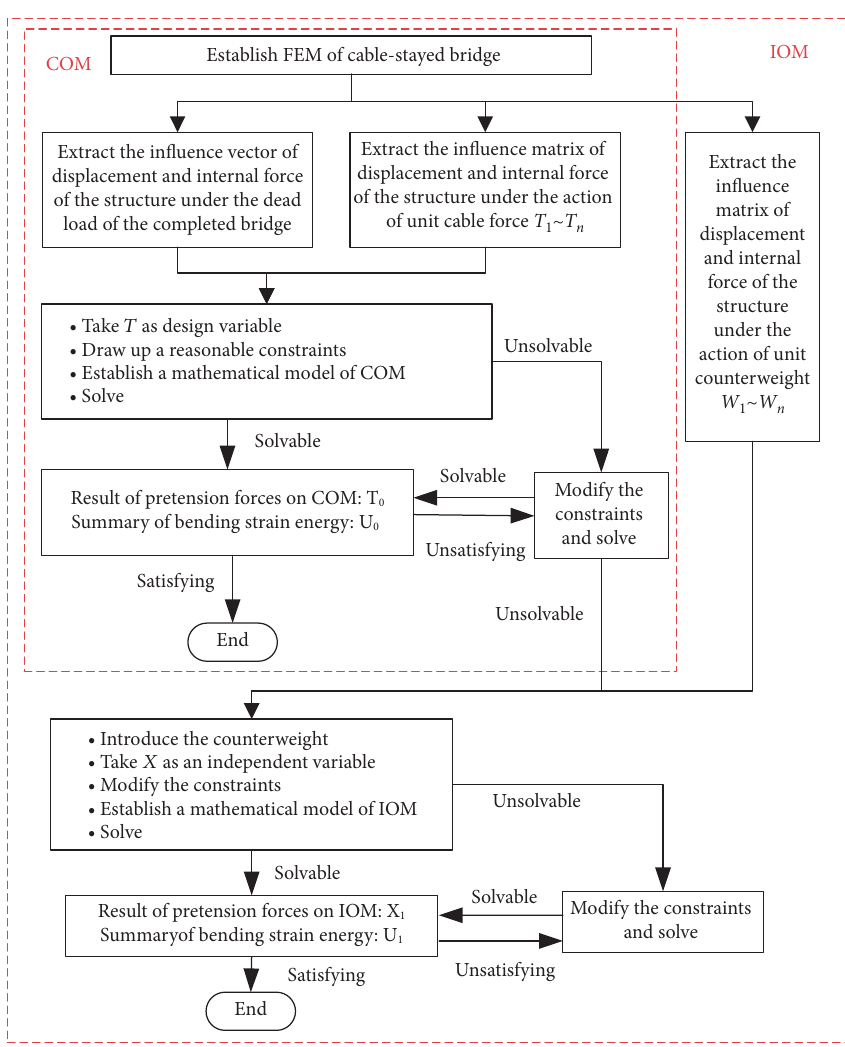
Figure 3: Flow chart of counterweights to all positive effect points ( W 11 ∼ W 13 in Figure 4), but only adds one counterweight at W 11, the most efficient node. After adding the counterweight, the cable force distribution did not change significantly. Figure 8. Regardless of whether PM or COM is used, the bending moment of the main girder is essentially the same, but the bending moment at the bottom of the pylon using COM is only half of that in PM, indicating that the stiffness of the pylon in this example is small, and the bending moment changes are more sensitive to the main girder. Compared with the opti- mization of a cable-stayed bridge without considering coun- terweights, the IOM significantly improves the bending moment of the outer main girder section of the side span, and at the same time, the bending moment of the bridge tower is almost zero. Noticing the magnitude difference between the bending moments of the pylon, the improvement of the bending moment of the pylon is not significant in Figure 6. The difference of 3e13 is only 1/8 of the value of COM, which can be